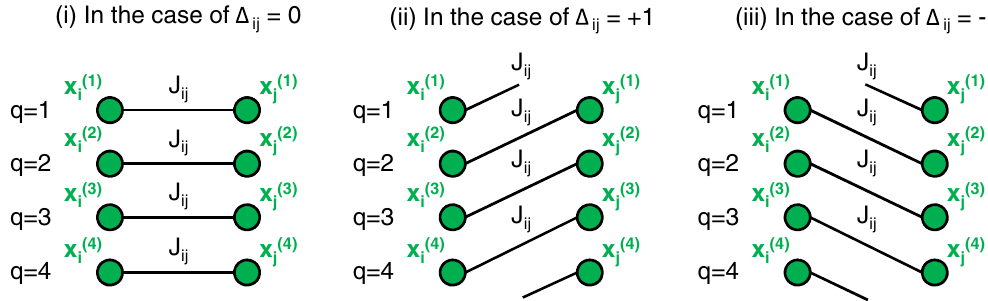
Figure 3. Local interactions generated by the first term of Eq. (10). Δ ij ≠ 0 causes interactions between different components.